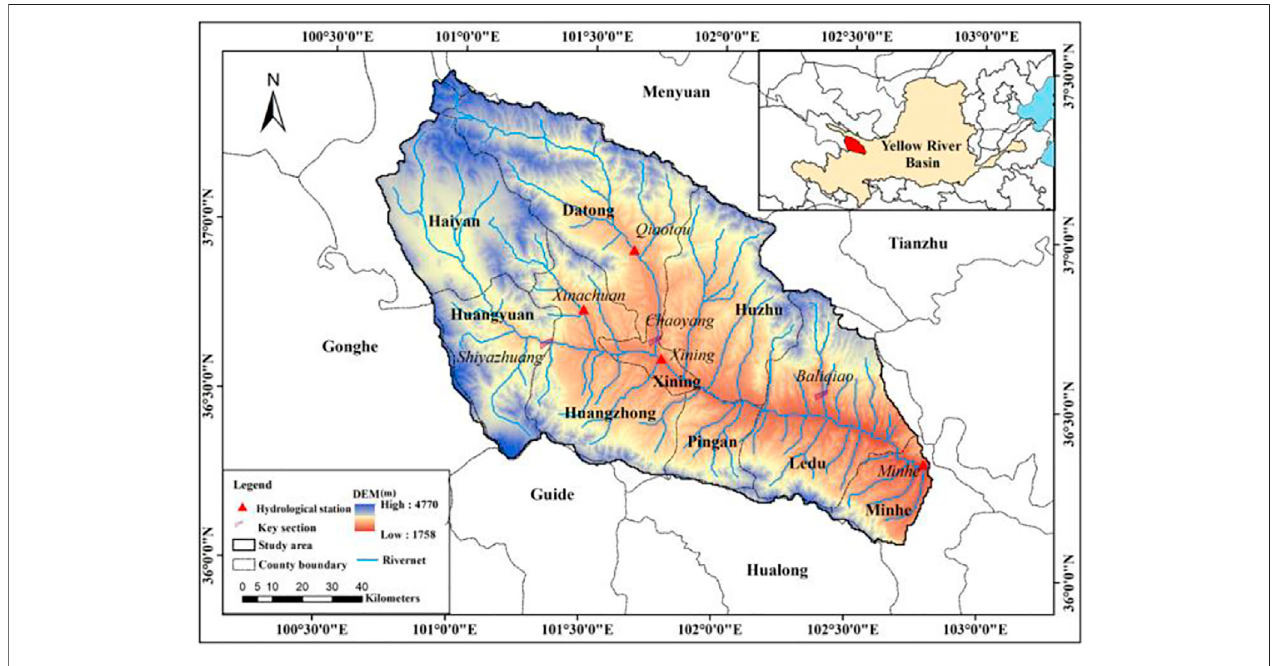
FIGURE 1 | Location of the Huangshui River Basin.